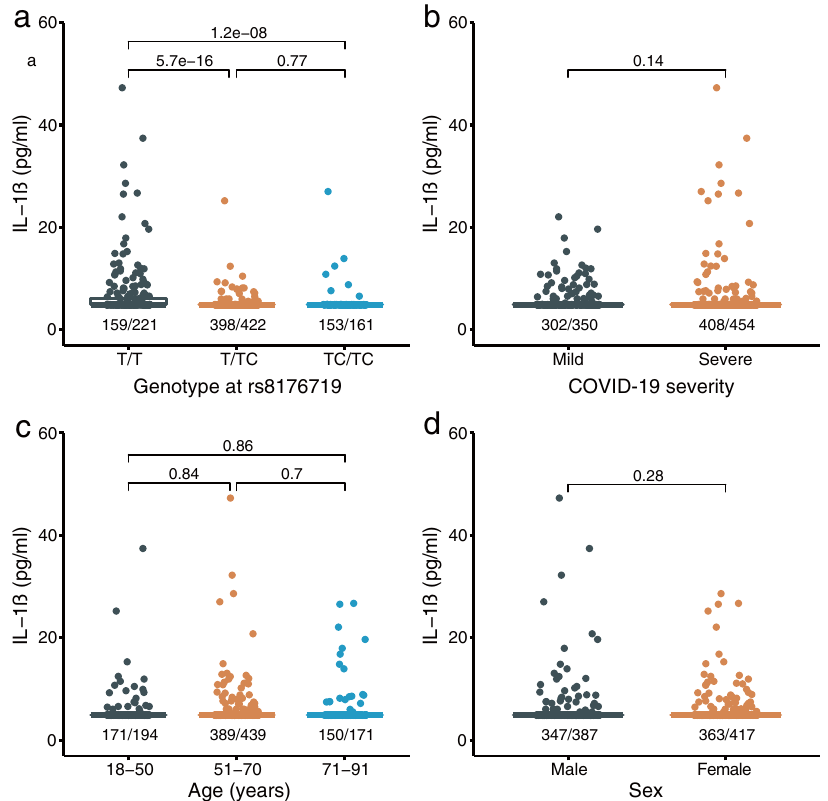
Fig. 2 Comparison of serum level of IL-1 β in different groups. Serum level of IL-1 β between groups de fi ned by the genotype at rs8176719 ( a ), COVID-19 severity ( b ), age ( c ), and sex ( d ). P values between groups, which are indicated above the horizontal line, were derived from Wilcoxon rank-sum tests. The number of samples below the limit of detection (5 pg/ml) and the total number of samples in each group are indicated below the box plot, separated by “ / ” . Source data are provided in Supplementary Data